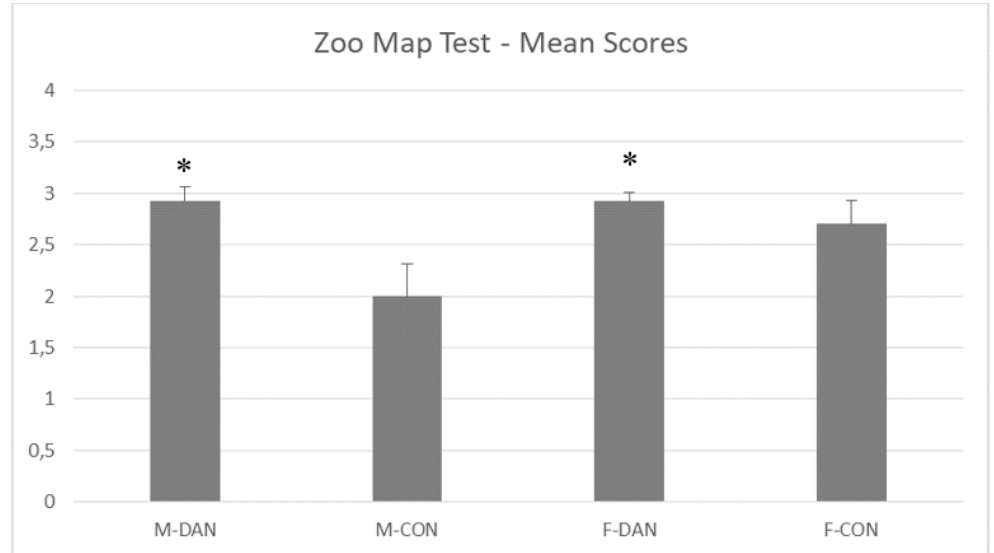
Figure 3. Zoo map test. Note that dancing groups outperformed controls. This indicates that they are more efficient in planning. Male dancing (M-DAN); female dancing (F-DAN); male control (M-CON); female control. Mean + SEM. * Significant differences with the control counterpart ( p <0.005).